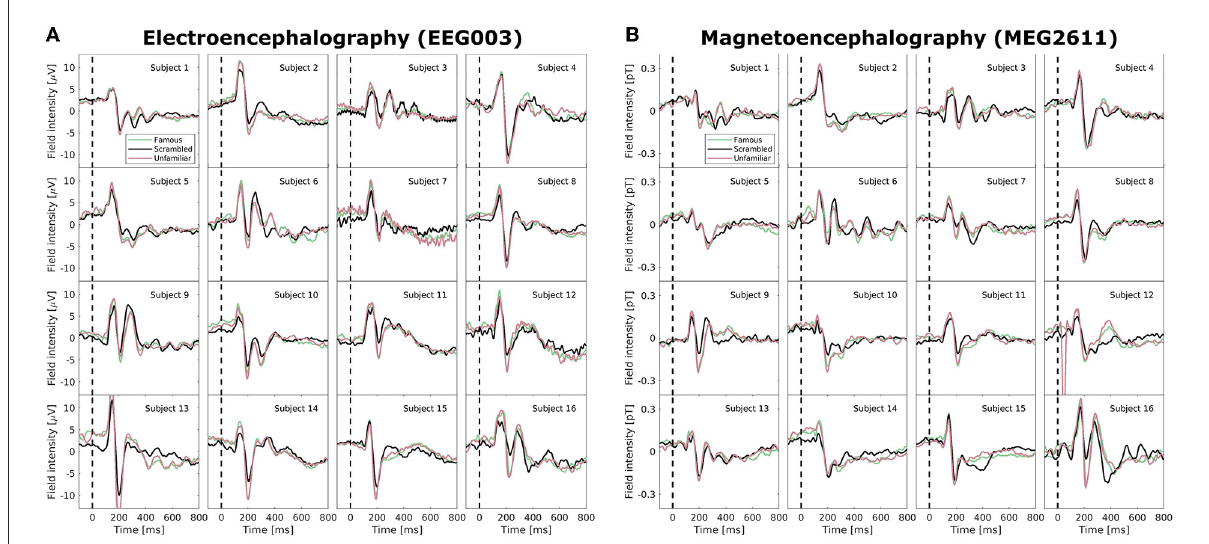
FIGURE2 Average mean-subtracted time-locked subject event related potentials (ERPs) after preprocessing but without normalization for the three face perception conditions (familiar, unfamiliar, scrambled). (A) A selected electroencephalographic electrode (EEG003) located near the right occipital lobe. (B) A selected magnetoencephalographic magnetometer (MEG2611) located near the right temporal